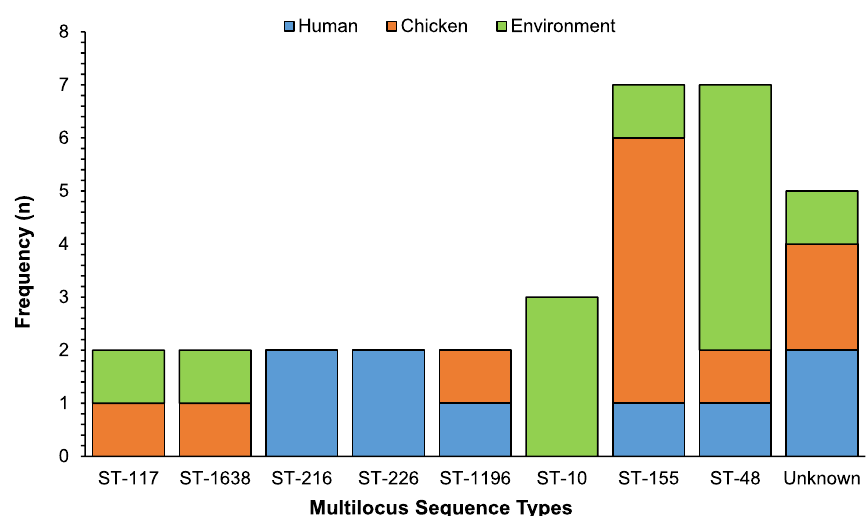
Fig. 3 Multilocus Sequence Types for PMQR Escherichia coli isolates ( n 70) recovered from humans, chickens, and poultry environments. Each bar = represents the various PMQR E. coli sequence types for isolates recovered from humans, chickens, and poultry farm/ market